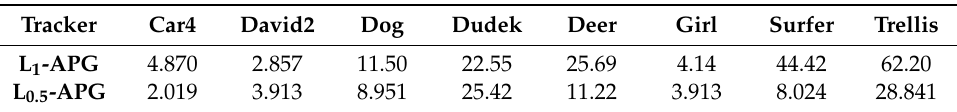
Table 1. The center location error (CLE) average of the L 0.5 -accelerated proximal gradient (APG)